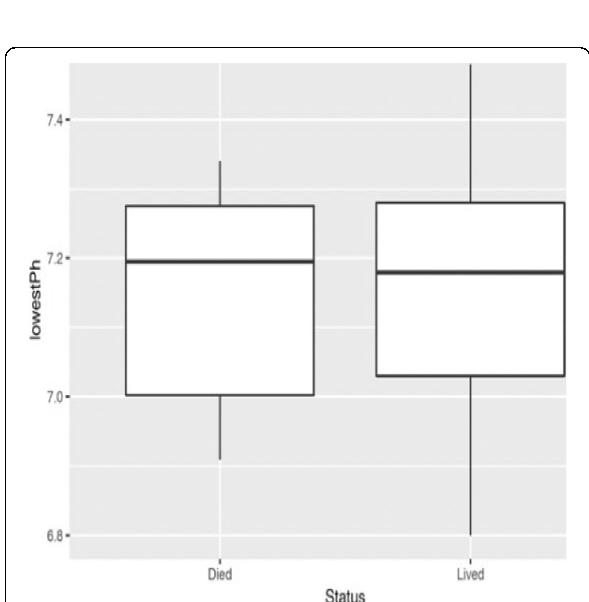
Fig. 2 (abstract 001355). Box Plot of lowest pH amongst Emergency DKA survivors and